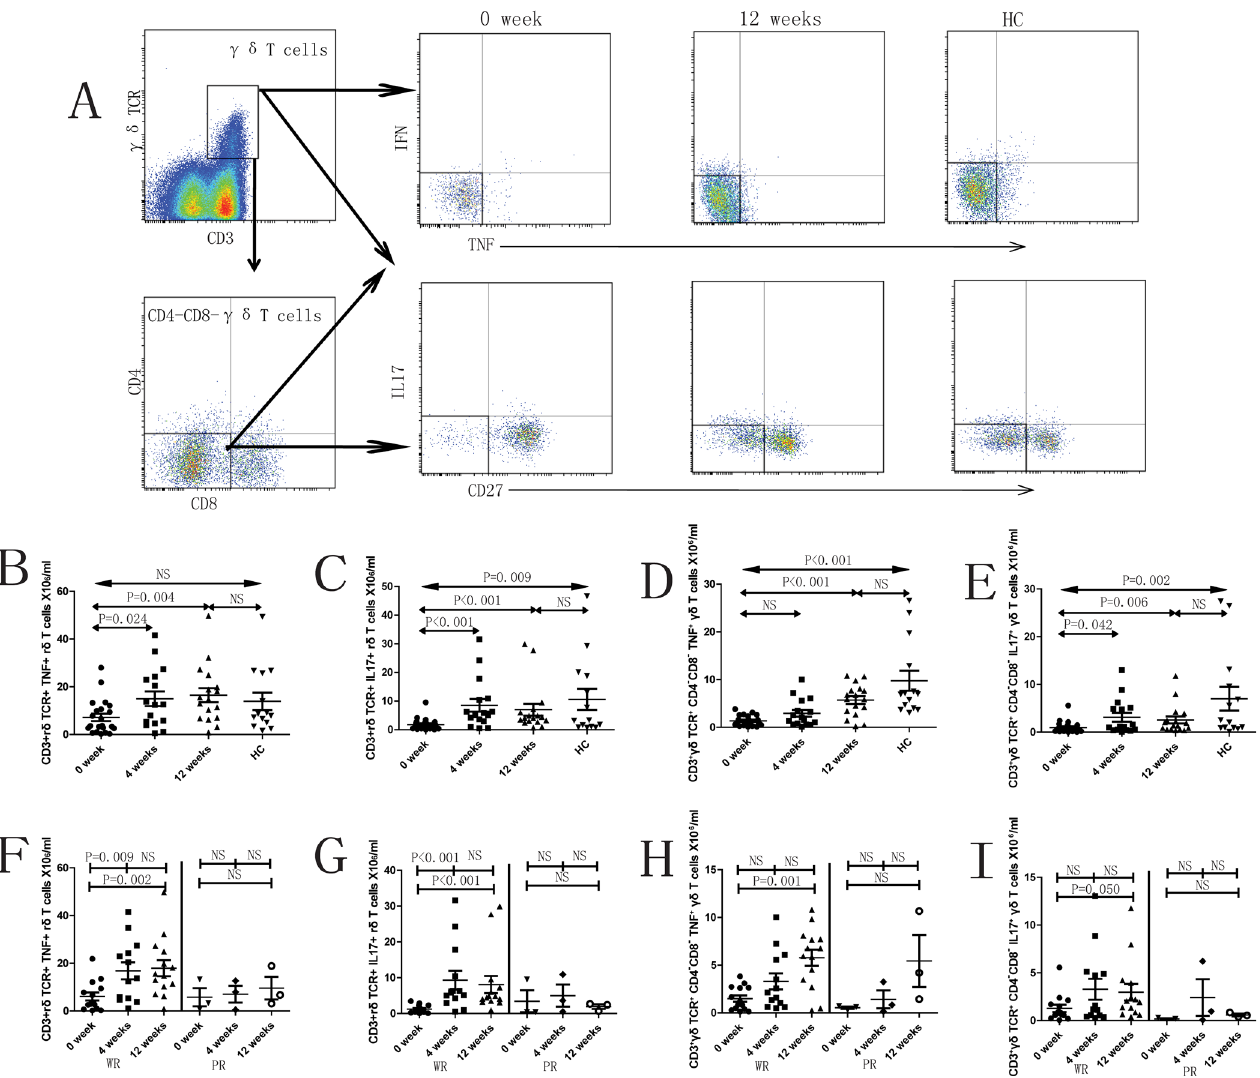
Fig 2. Characterization of different subsets of CD3 + γδ TCR + cells in SLE patients. A. The panels in this section show the gating strategy employed for the analysis of γδ T cells and subsets. Peripheral venous blood derived leukocytes were stained with different fluorescent antibodies and after lysis of red blood cells, the remaining cells were gated on living lymphocytes and further gated on CD3 + γδ TCR + cells and CD3 + γδ TCR + CD4 - CD8 - cells, and then further gated on IFN- γ + , TNF- α + , IL17 + and CD27 + cells, respectively. The frequencies of different subsets of γδ T cells were analyzed by flow cytometry. B — I. Flow cytometry results represented as the scatter dot plots of γδ T cells and subsets in healthy controls (HC) or in SLE patients before and after therapy (treatment time is indicated). SLE patients are further grouped as responders (R) and non-responders (NR) based on response to